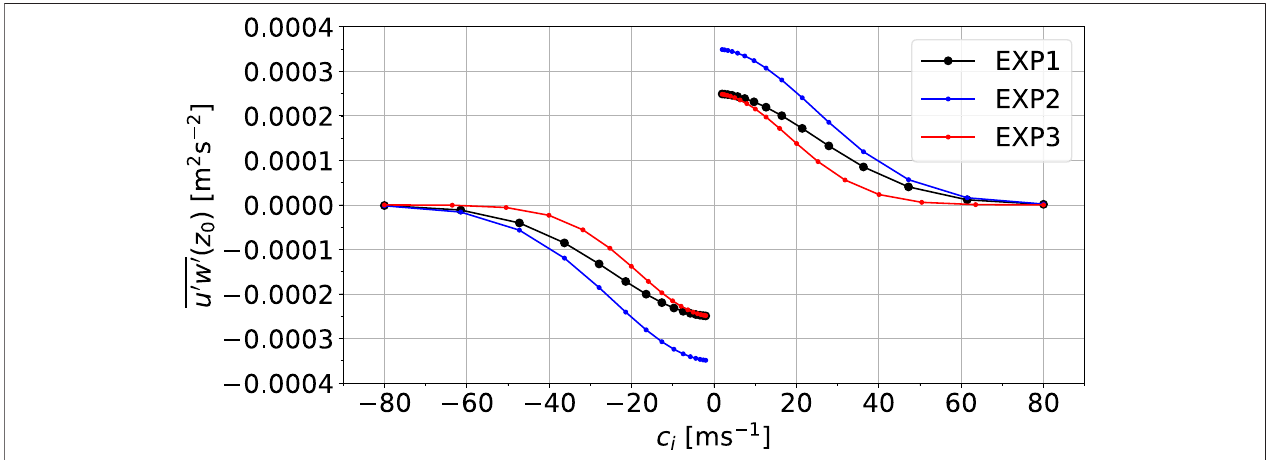
FIGURE1| SpectraofGWmomentum fl uxesatthesourceleveloftheGWparameterization, u ′ w ′ ( z 0 ) ,asafunctionofhorizontalphasespeeds c i forEXP1(black), EXP2 (blue) and EXP3 (red).